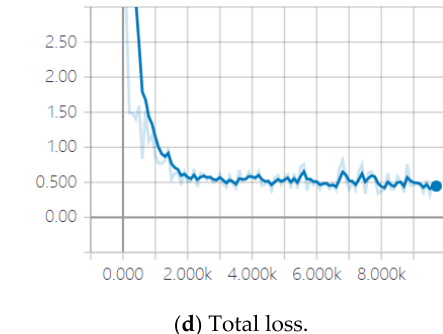
( c ) Confidence score loss. ( d ) Total loss. Figure 7. Loss graphs of the training stage, taking the experiment on the Caltech–Zhang as an example. Where, ( a ) is the bounding box loss; ( b ) is the classification loss; ( c ) is the confidence score loss; ( d ) is the total loss, which is the sum of previous three loss functions.